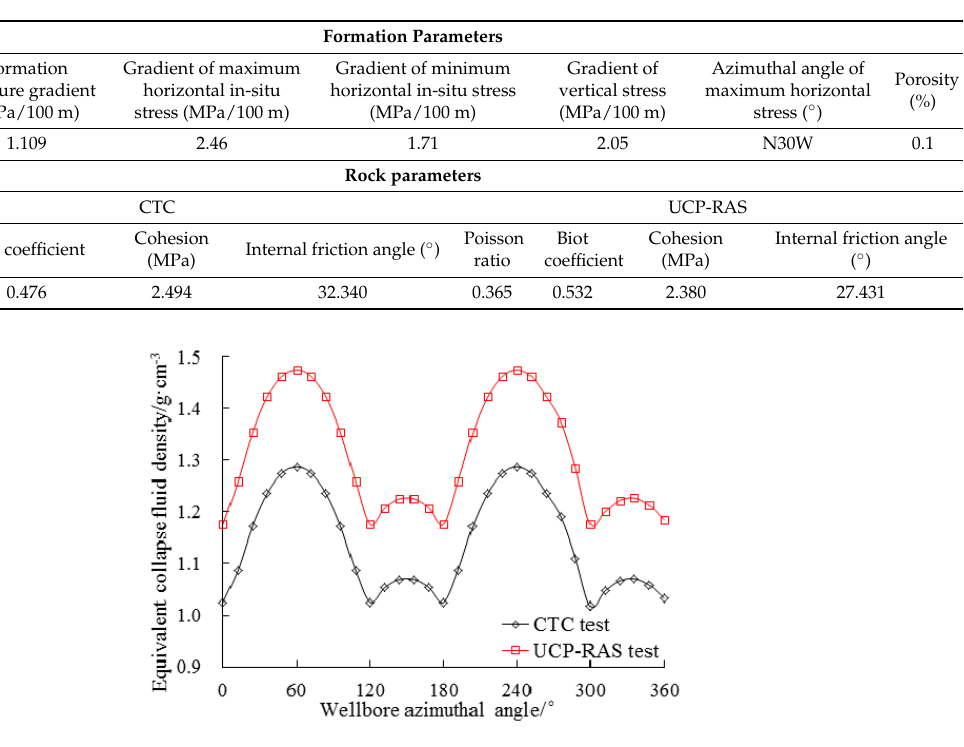
Figure 15. Equivalent collapse fluid density (minimum drilling fluid density for well stability) considering the wellbore azimuthal angle of the horizontal well.